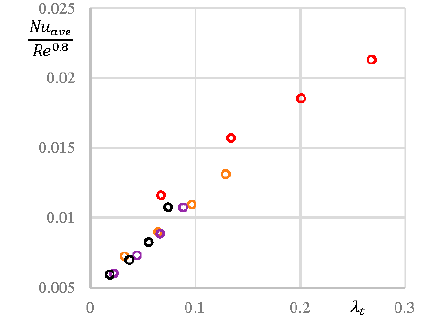
Figure 13. Variations of (cid:3015)(cid:3048) (cid:3276)(cid:3297)(cid:3280)